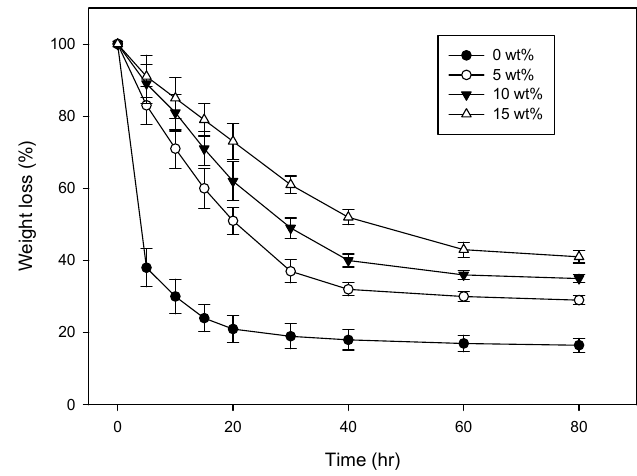
Figure 1. Moist retention ability of CH–CMC hydrogel with different content of honey in CH–CMC hydrogel; radiation dose is 75 kGy.